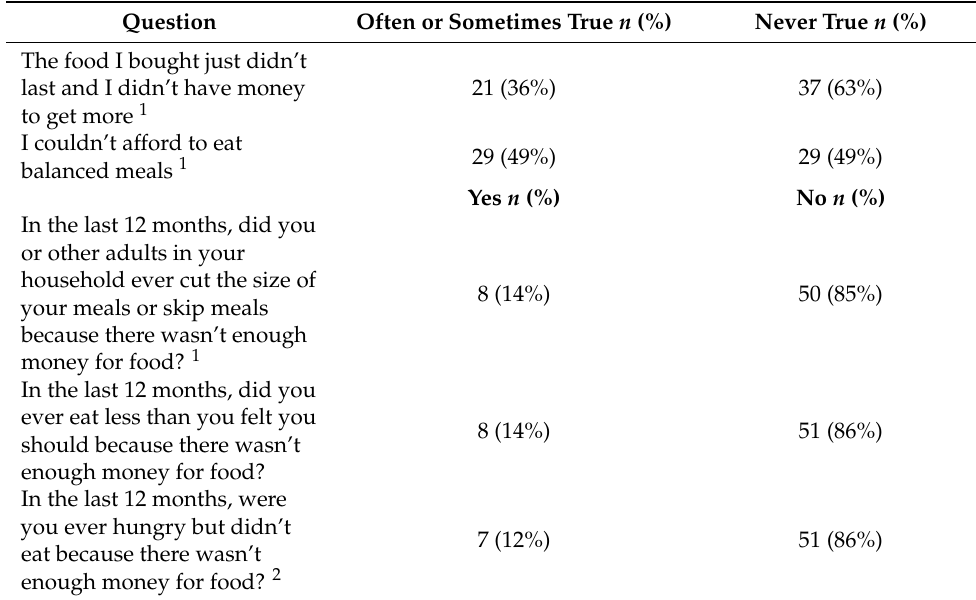
Table 2. Participant food insecurity characteristics of focus group participants ( n =